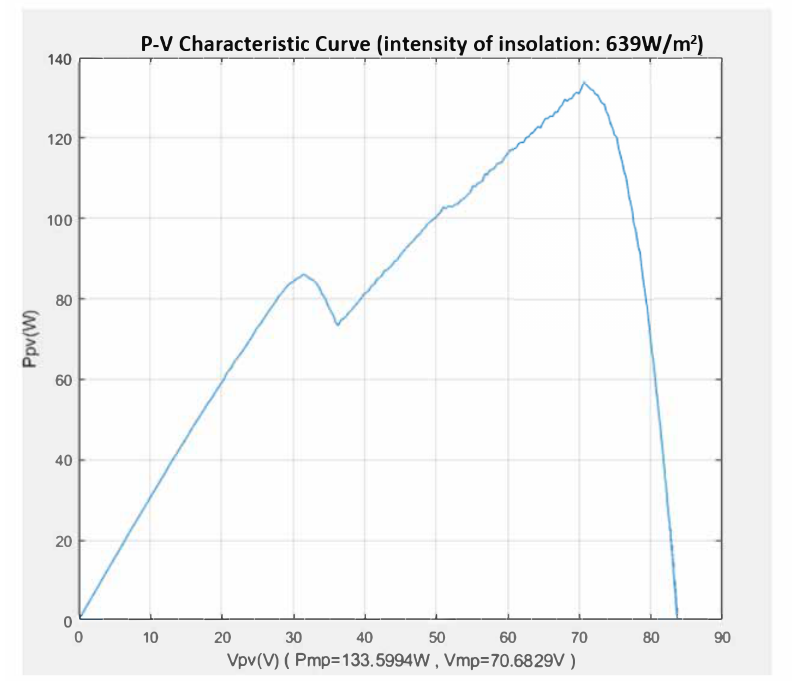
P-V Characteristic Curve (intensity of insolation: 639W/m 2 ) 140 �-�--�--�--��-��-�-�--�-��